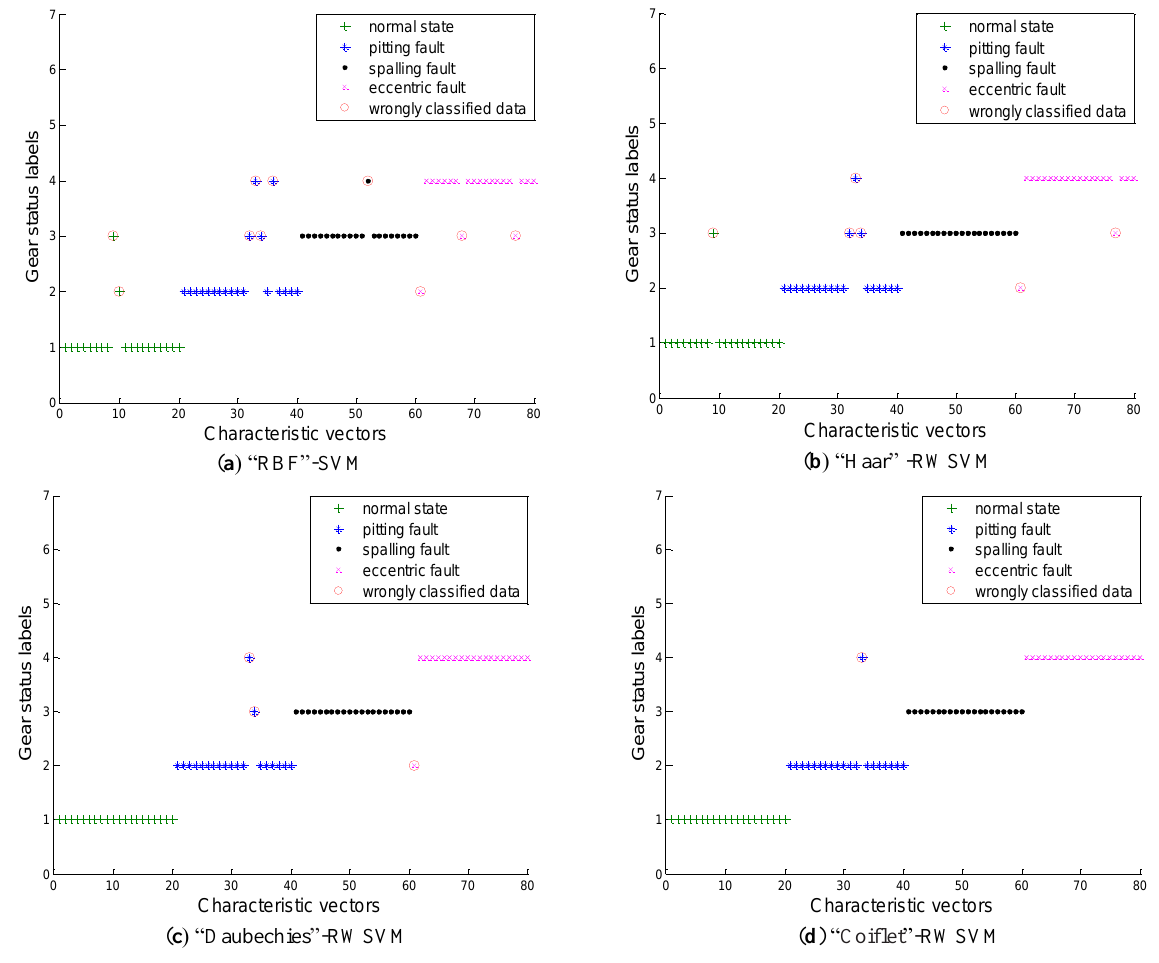
Figure 10. Results of the SVM classification for the experimental